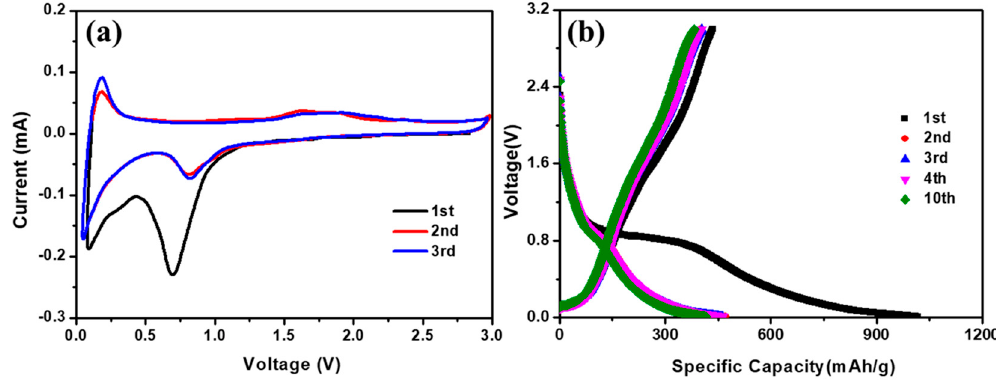
Figure 4. ( a ) Cyclic voltammetry (CV) profiles with the voltage window of 0.01–3.0 V and the scanning rate of 0.05 mV s − 1 , and ( b ) charge–discharge profiles of the Fe/Fe 3 C@GC cell at 45 mA g − 1